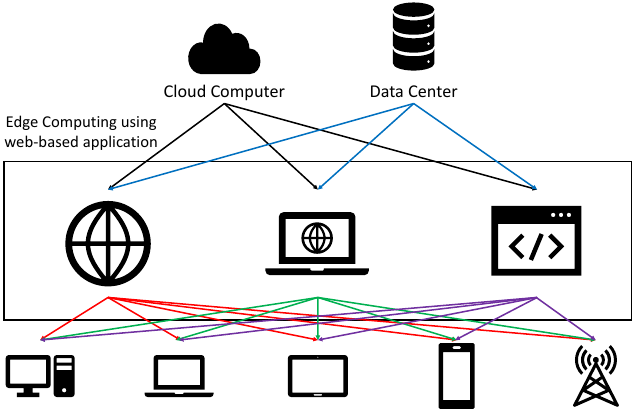
Figure 12. Edge computing structure using Web